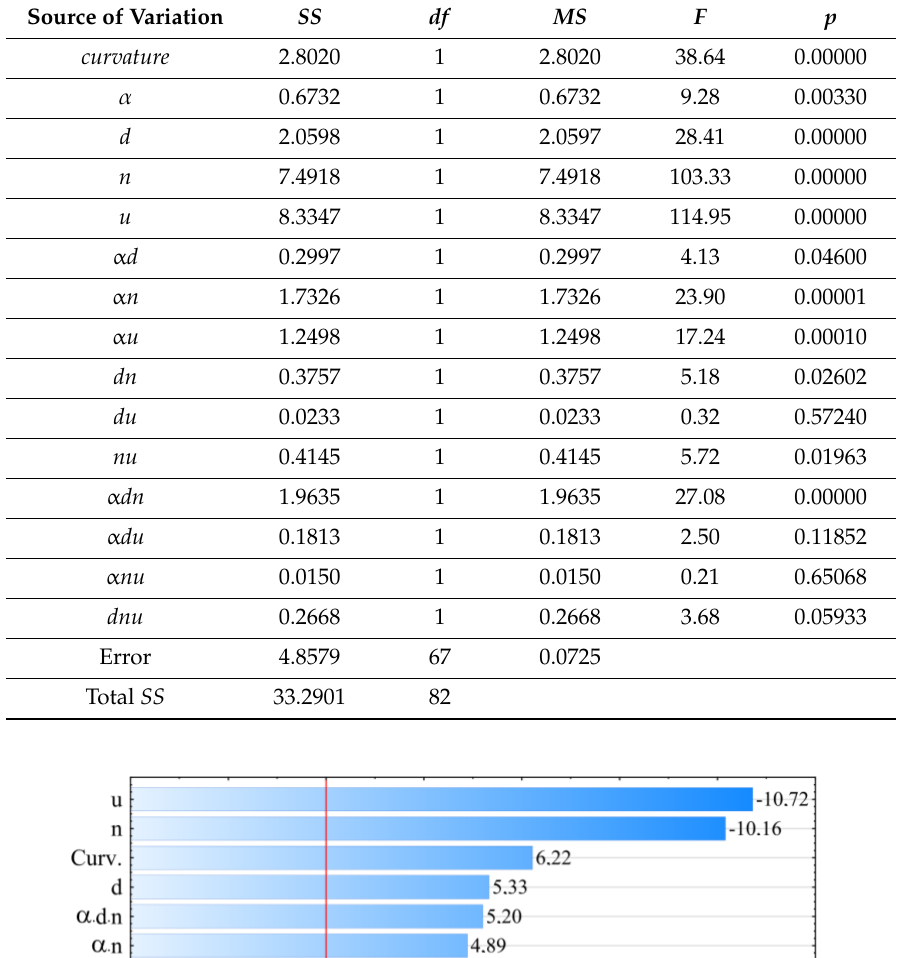
Table 4. Model of elongation at tensile strength ε —ANOVA table. R 2 = 0.85; R adj 2 = 0.82 (markers as in Table 2).